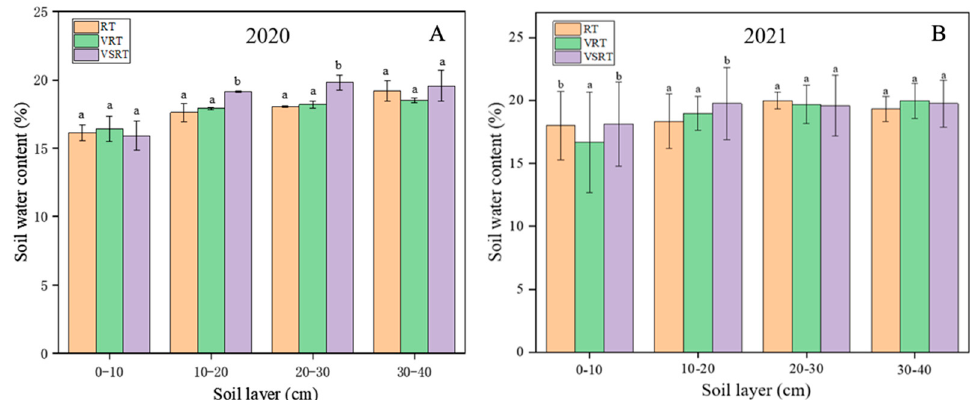
Figure 3. Soil water content of the 0–40 cm soil layer with the three tillage methods. ( A ): The soil water content in 2020; ( B ): The soil water content in 2021. Different lowercase letters in the same soil layer indicate significant differences at a p < 0.05 level. Rotary tillage, RT; vertical rotary tillage, VRT; vertical smashing rotary tillage, VSRT.